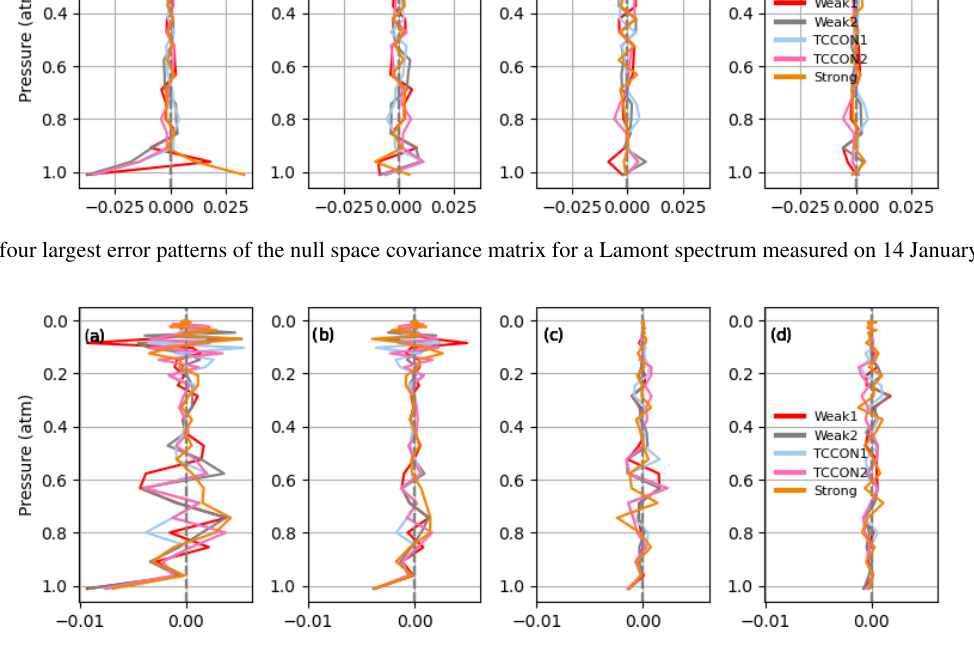
Figure D7. Same as Fig. D6 but for the measurement noise covariance matrix.